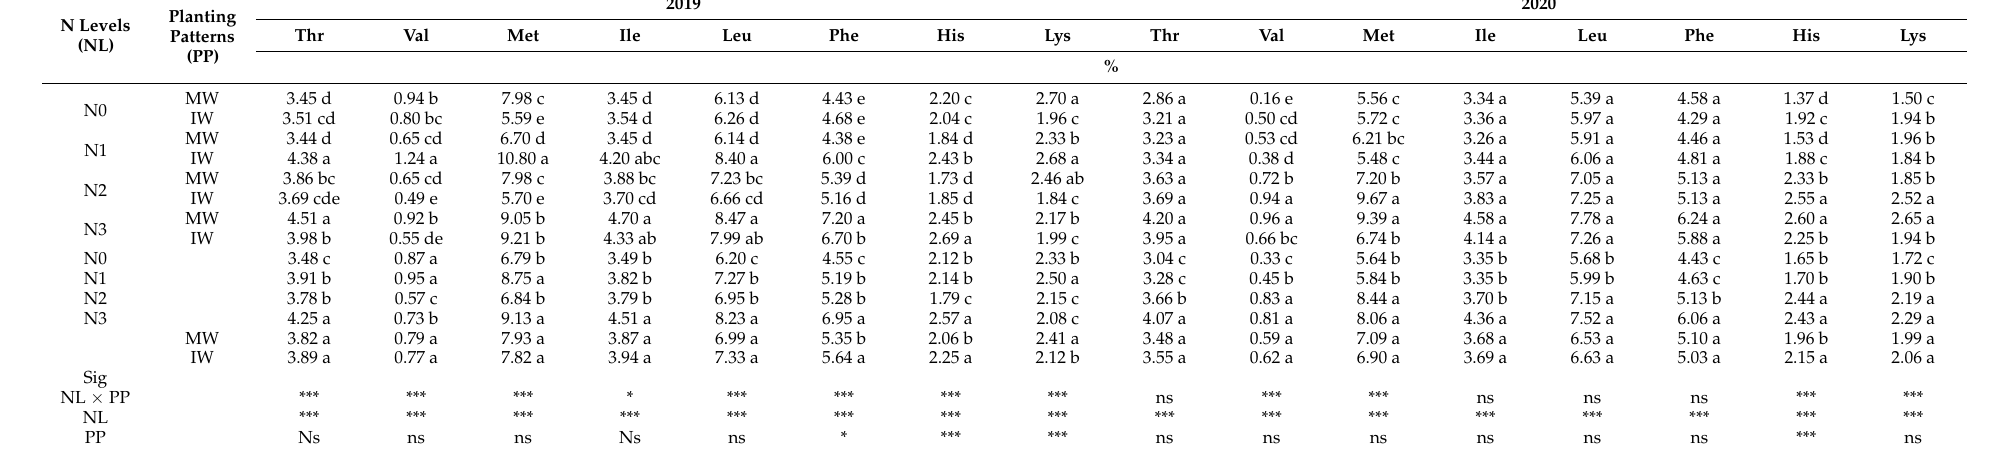
Table 4. The fraction content of each essential amino acids in grain for inter- and mono-cropped wheat grain under different N levels.